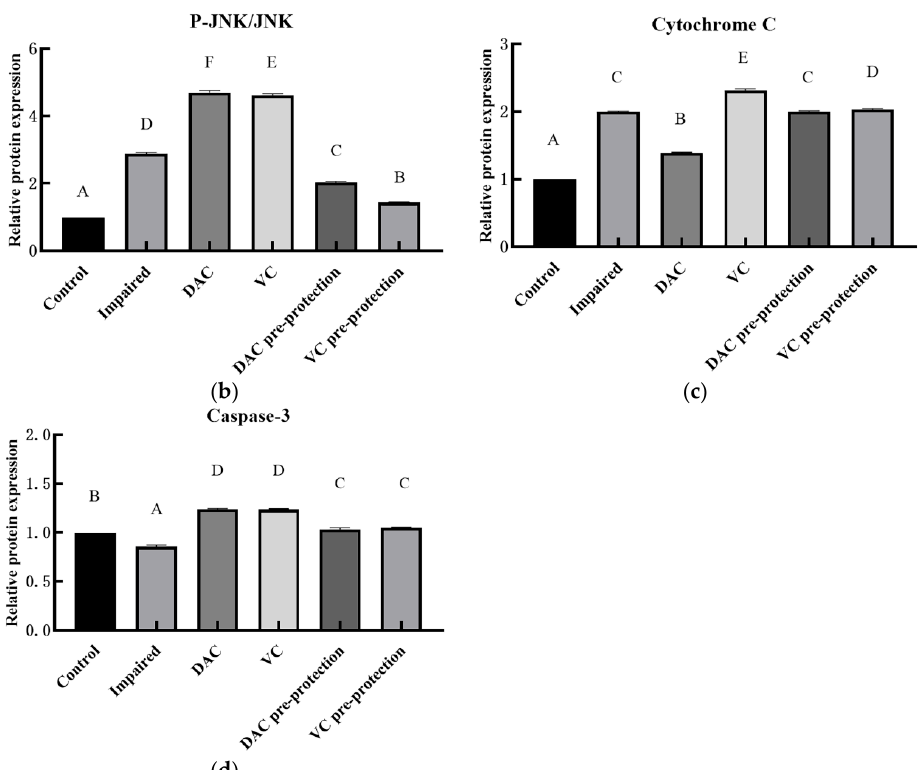
Figure 4. Effect of DAC pre-protection on relative expression of key proteins in MAPK-JNK signaling pathway in GMEC. The band of the western blot is shown in (a); the proteins that play key roles in MAPK-JNK pathway are shown in (b) P-JNK/JNK, (c) Cytochrome-C, and (d) Caspase-3.